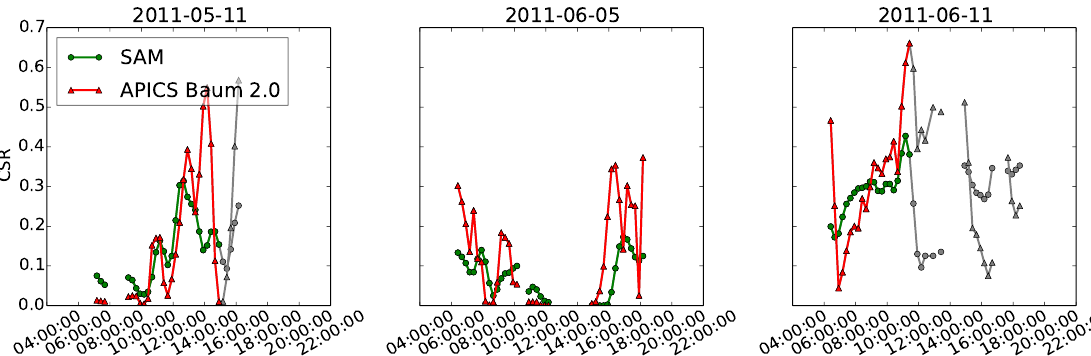
Fig. 11. Exemplary excerpt of the circumsolar ratio (CSR) time series used for the validation. In total 107 data pairs are shown. Grey symbols indicate that water clouds were identified in the manual screening of sky camera images. Time is given as UTC.